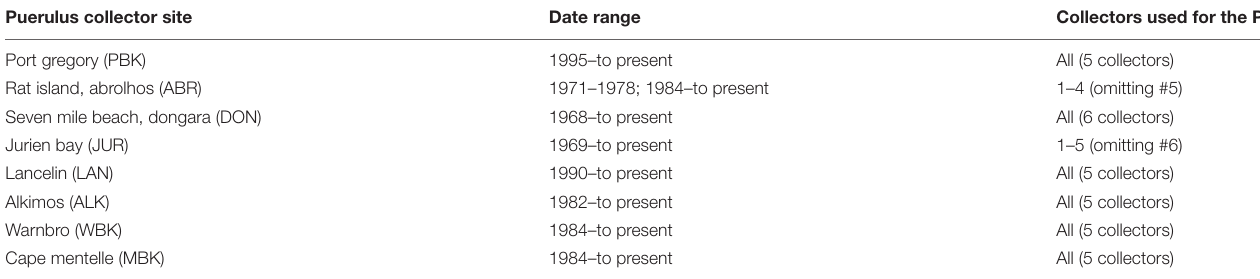
TABLE 1 | Summary of identified contrasts in puerulus settlement patterns before and after the P. cygnus recruitment failure in